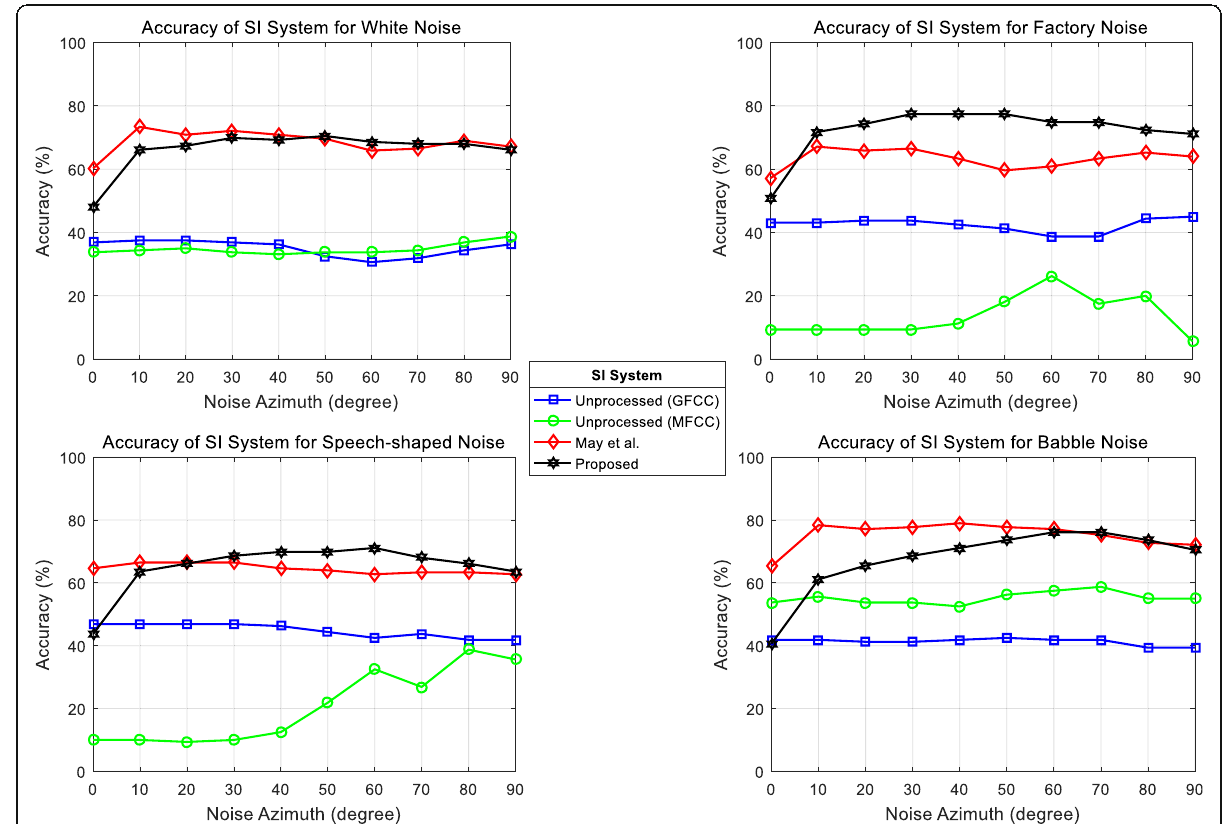
Fig. 7 The accuracy of the SI systems obtained in anechoic and additive noise conditions with four types of noises at SNR = 5